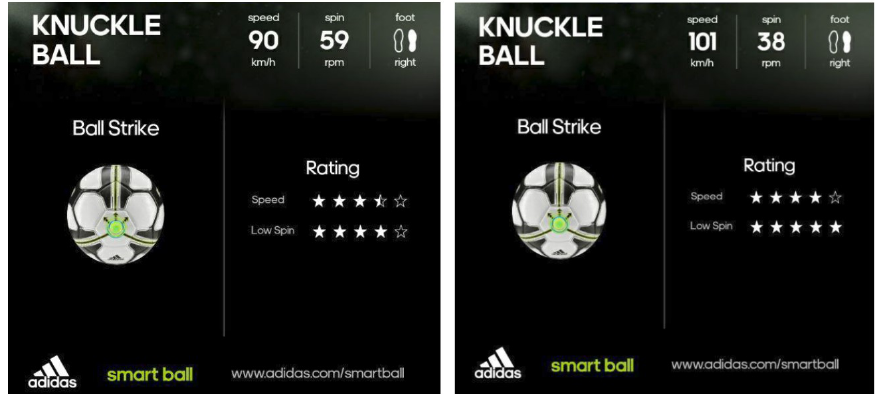
Figure 11. Example display from miCoach Smart Ball